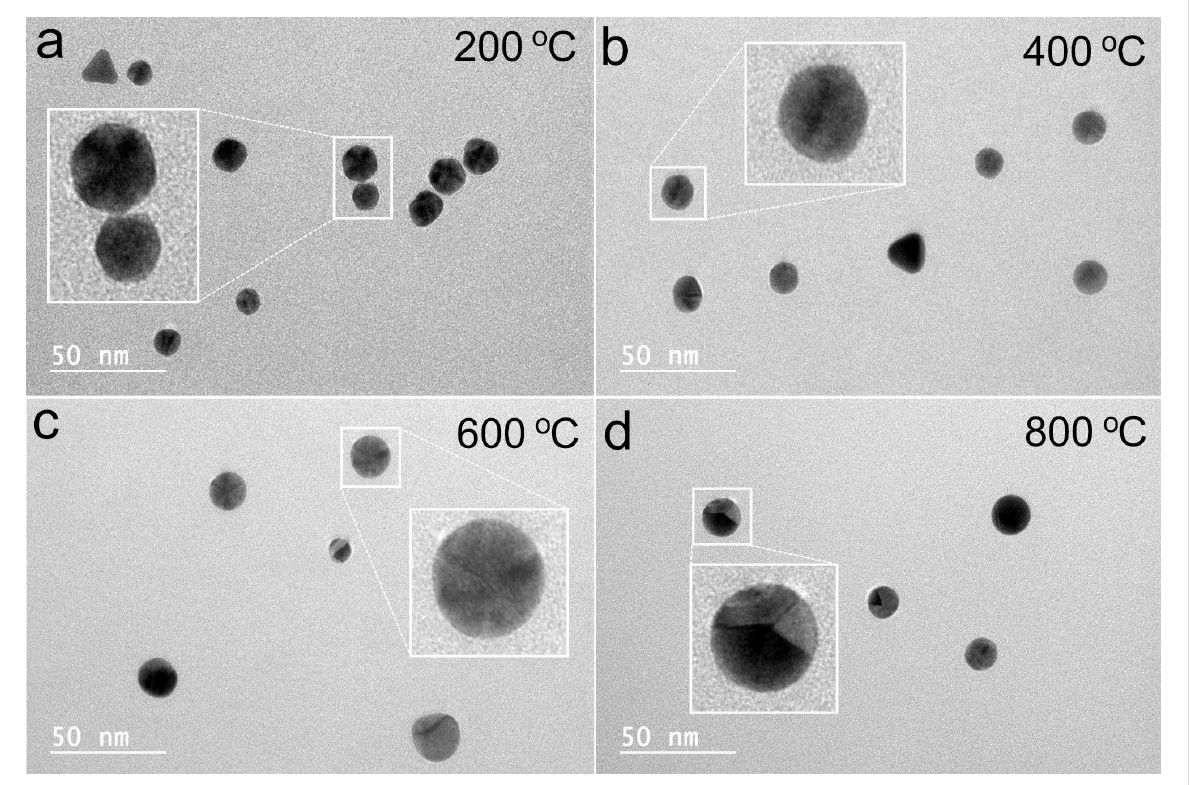
Figure 2: Morphology of the Au NPs and after annealing at (a) 200 (b), 400 (c) 600 (d) and 800 °C. Slight rounding of the NPs can be seen at higher temperatures.